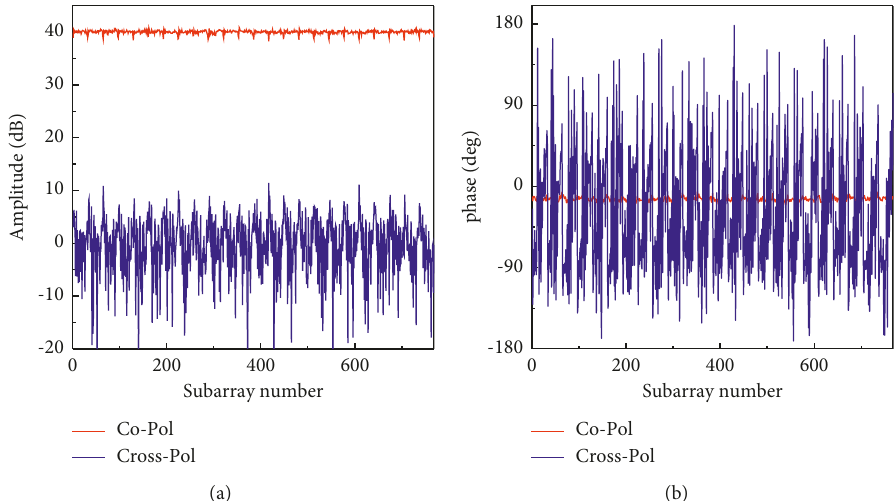
Figure 5: Calculated field value of all waveguide subarrays. (a) Amplitude for copolarization and cross-polarization. (b) Phase for copolarization and cross-polarization. Table 3: Cross-polarization level results of Q mode and WQ mode. Beam